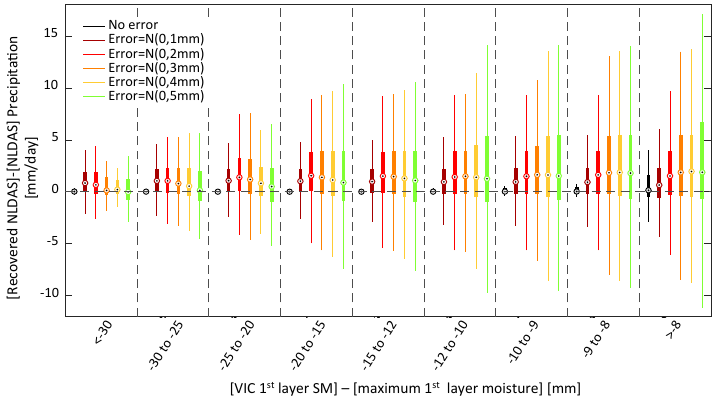
Figure 7. Error in recovered NLDAS precipitation given surface moisture condition. Recovered NLDAS is based on using “truth” soil moisture and soil moisture with normal error: N (0.1mm), N (0.2mm), N (0.3mm), N (0.4mm) and N (0.5mm). Statistics provided in Table